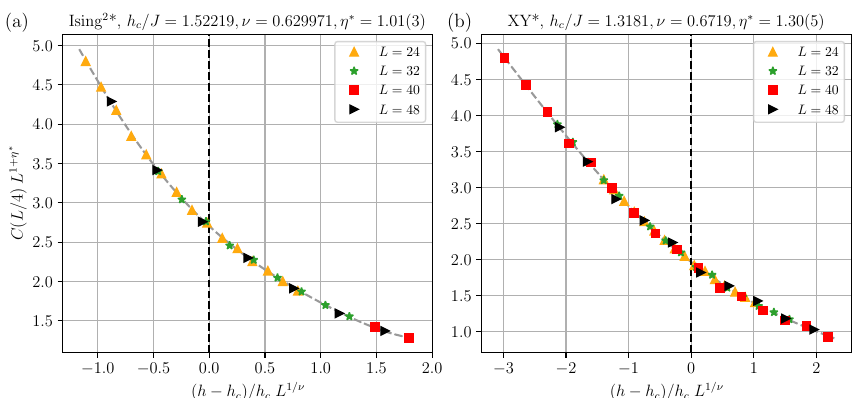
Figure 9: Collapse plots for correlation function C ( L / 4 ) across the (Ising 2 )* transi- / J = 0.625 (b). The dashed, grey line shows a tion (a), and the XY* transition for J AT polynomial fit of the data as a guide to the eye. We use the known critical exponents ν for the Ising and XY transitions [ 51 ] in (a), (b), respectively. The critical exponents η ∗ are chosen such that the best collapse of C ( L / 4 ) is observed (minimal root-mean- ∗ square distance of the data to the fit). The obtained values for η are much larger than the standard Ising or XY values due to the fractionalization of the quasiparticles. See text for further